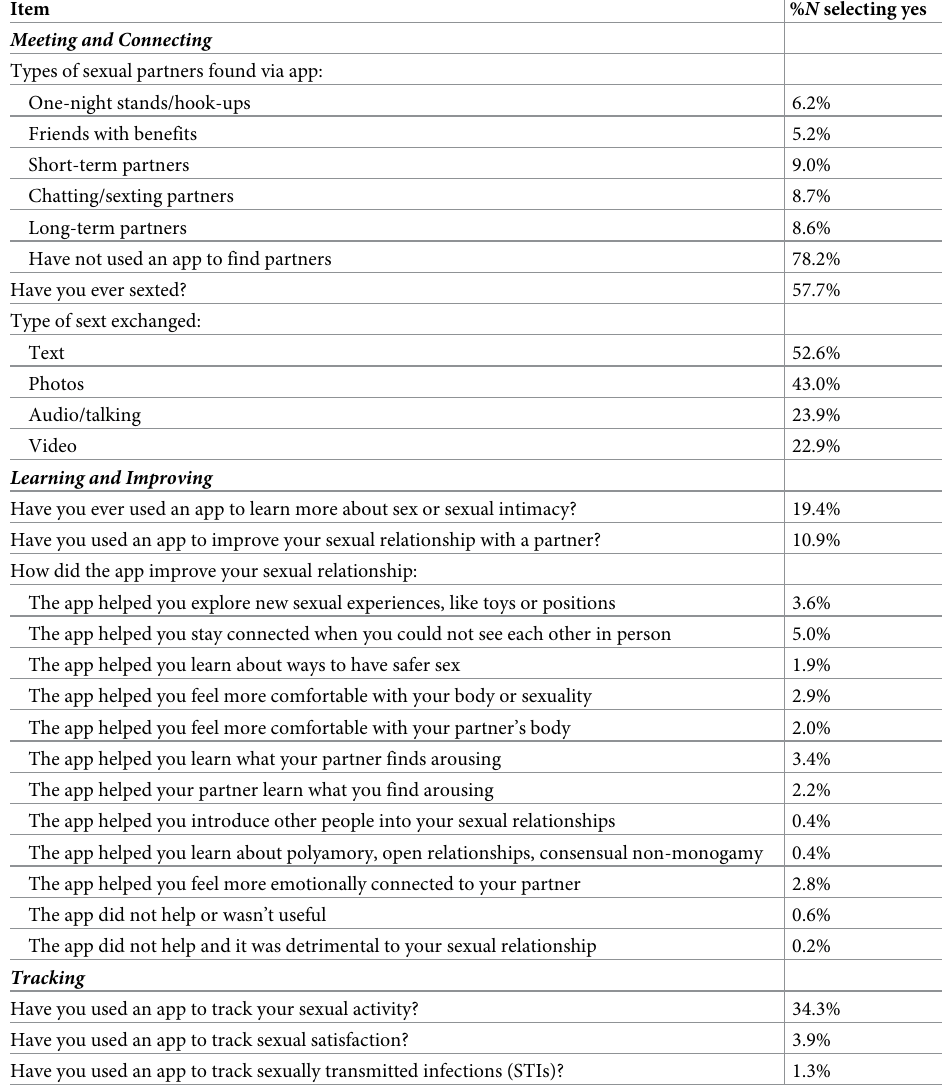
Table 1. Frequencies for All Sex-Tech Items for the Overall